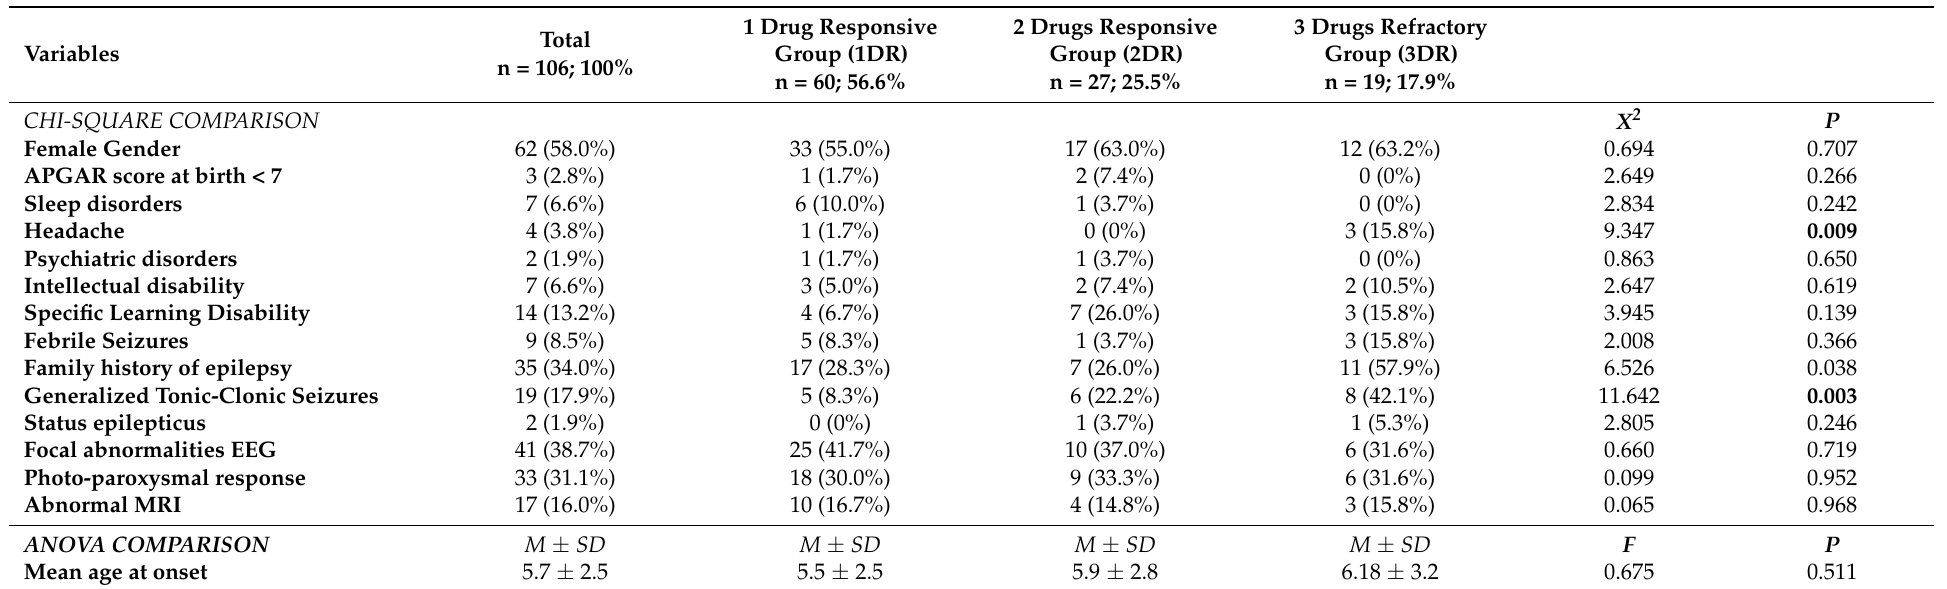
Table 1. Clinical and EEG characteristics based on the response to AED in patients with CAE